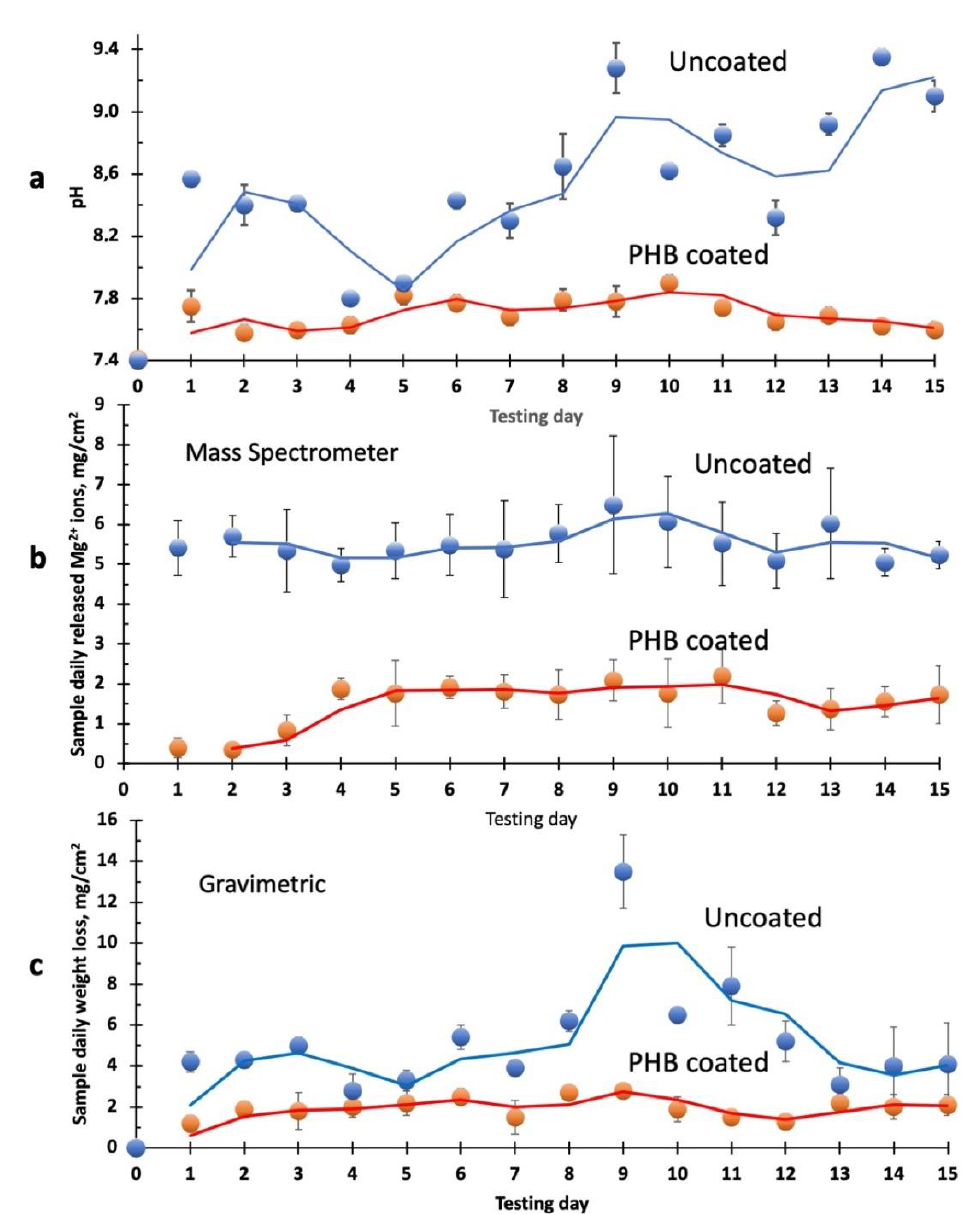
Figure 3. ( a ) pH of the SBF corroding medium, ( b ) mass of Mg 2+ corrosion ions released in the SBF, and ( c ) gravimetric sample weight losses. Test were run according to ASTM-G31-72; SBF corroding medium was daily refreshed.